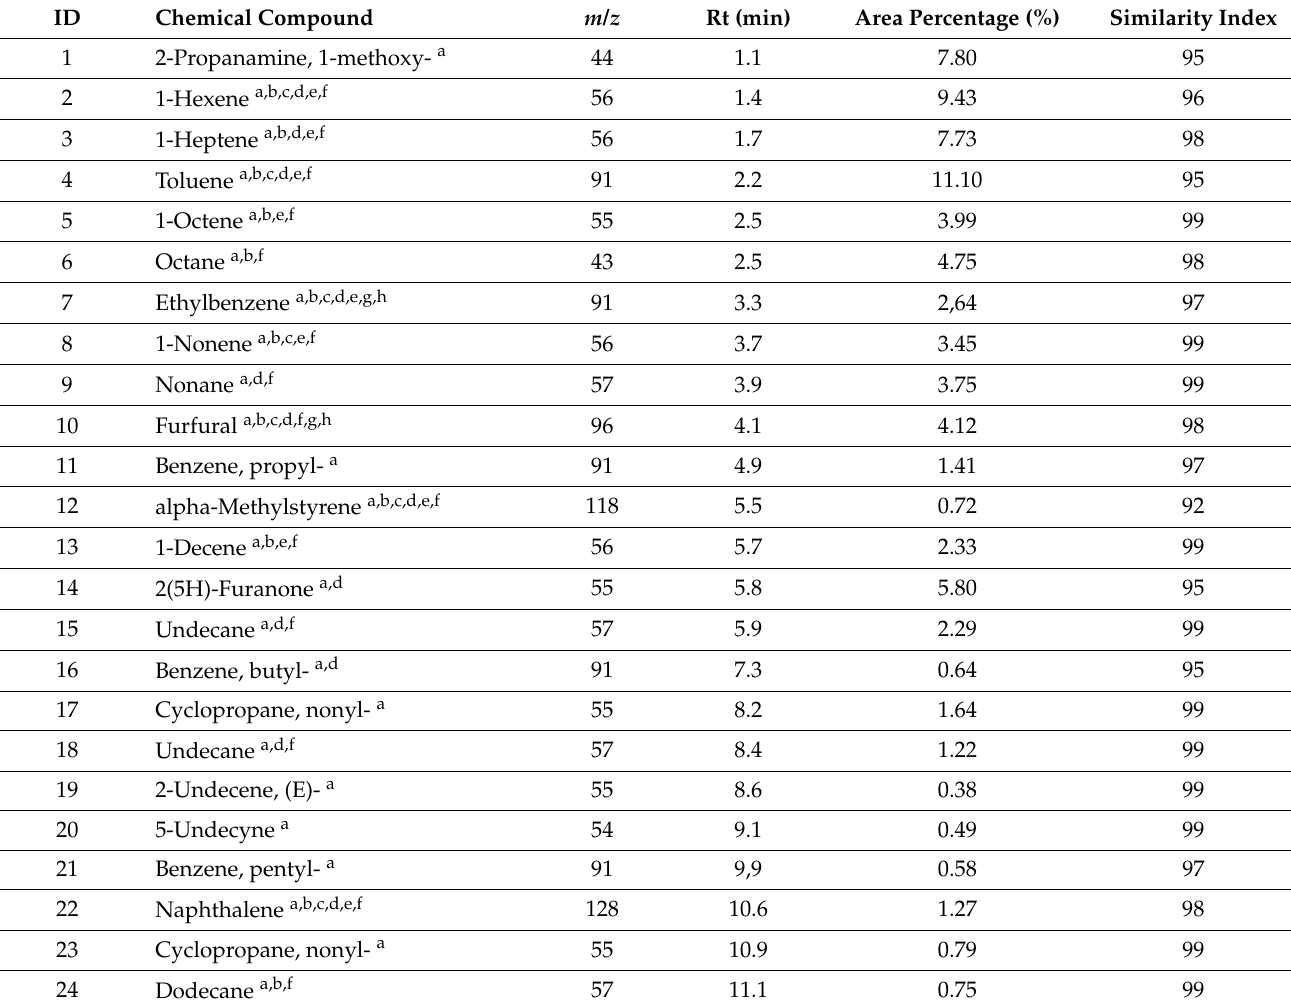
Figure 3. Chromatogram of reference detergent. The chemical compound as a pyrolytic product and quantitative indicators of deter- gents are shown in Table 4. Proposed identification by comparing with the chromatogram of standard polymers was performed and marked with font a, b, c, d, e, f, g, h as a superscript [19–26]. Table 4. Pyrolytic products and quantitative indicators of the detergent.